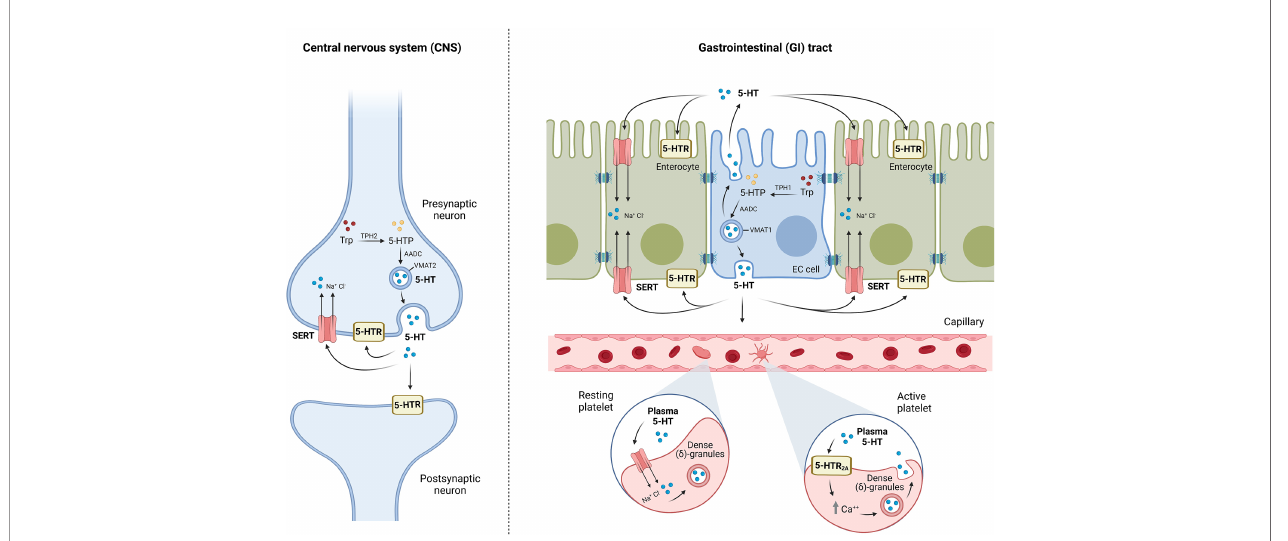
FIGURE 1 | Schematic representation of brain and intestinal serotonergic systems: “ ON/OFF ” and signaling mechanisms. “ ON ” mechanism refers to the synthesis of 5-HT by enterochromaf fi n cells (EC) in the gut and serotonergic neurons both in the gut and in the central nervous system (CNS). Tryptophan (Trp) is catalyzed by the enzyme tryptophan hydroxylase (TPH), TPH1 in EC cells, and TPH2 in neurons, to synthesize 5-hydroxytryptophan (5-HTP), which is converted to 5-HT by aromatic amino acid decarboxylase (AADC). 5-HT is stored into vesicles through the vesicular monoamine transporter VMAT (VMAT1 in EC cells, and VMAT2 in neurons) and fi nally released into the extracellular space. 5-HT can bind to different serotonin receptors (5-HTR) or uptake into neurons, enterocytes, or platelets by the serotonin transporter (SERT), ending 5-HT effects ( “ OFF ” mechanism). 5-HT is mostly stored in the dense ( d )-granules of platelets; however, the binding of plasma 5-HT to the platelet surface receptor 5-HT 2A initiates the mobilization of intracellular calcium stores for platelet activation, which promotes platelet degranulation, resulting in 5-HT release. Serotonin exerts its effects by signaling mechanisms through the 5-HT receptors located in postsynaptic and presynaptic neurons at CNS and intestinal serotonergic neurons, and in different cell types of gastrointestinal (GI) tract, but also in other systems such as the cardiovascular or immune